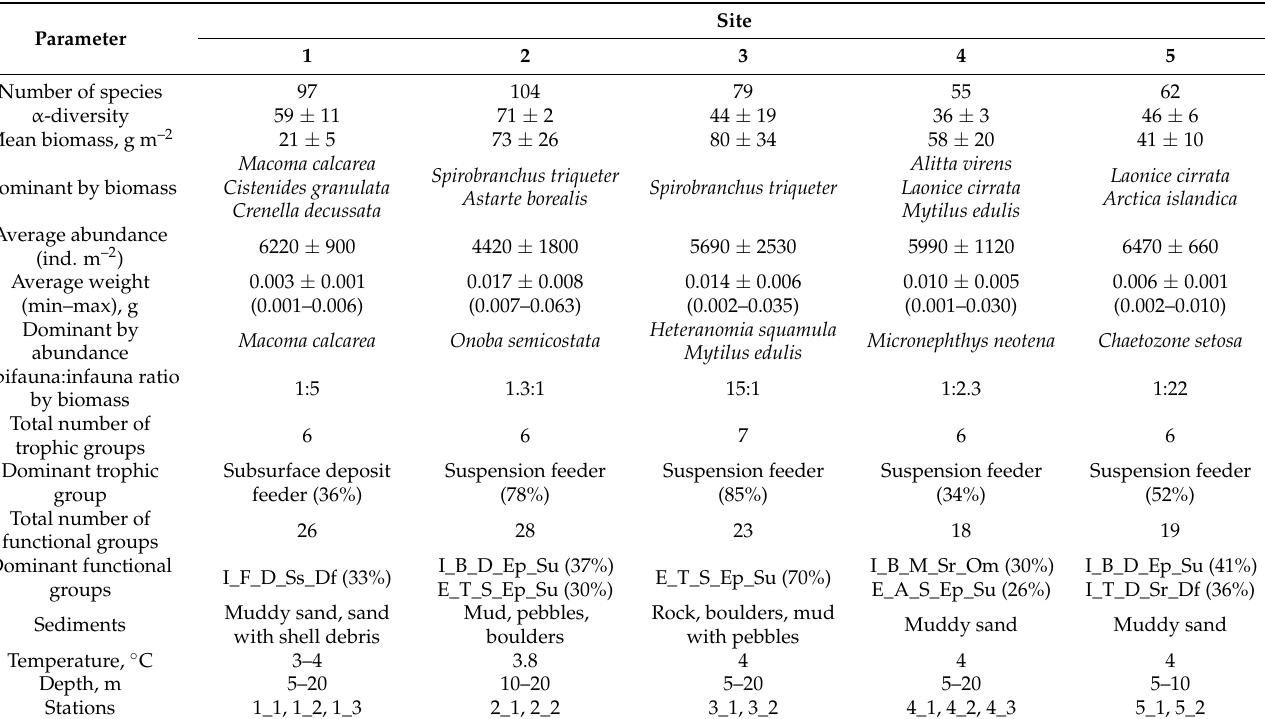
Table 2. Benthic community characteristics at five sites studied for food selectivity of red king crabs in Kola Bay, southern Barents